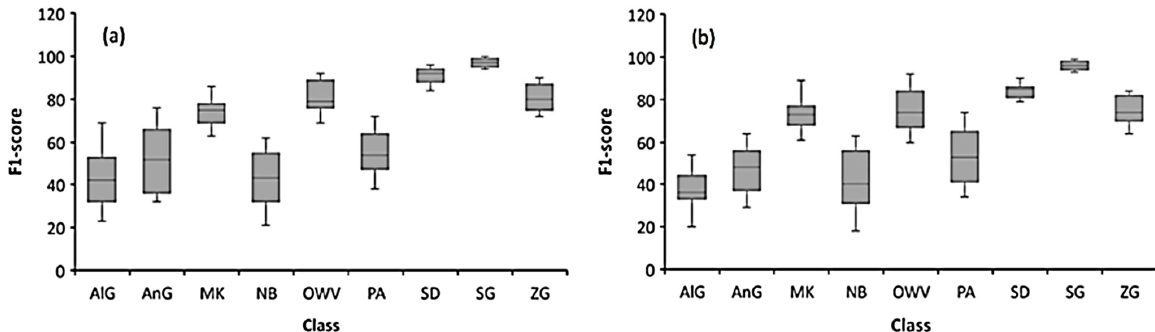
original dataset’s F1 ‐ score were 63.8 ± 3.9% for RF and 62.7 ± 4.3% for SVM. The over ‐